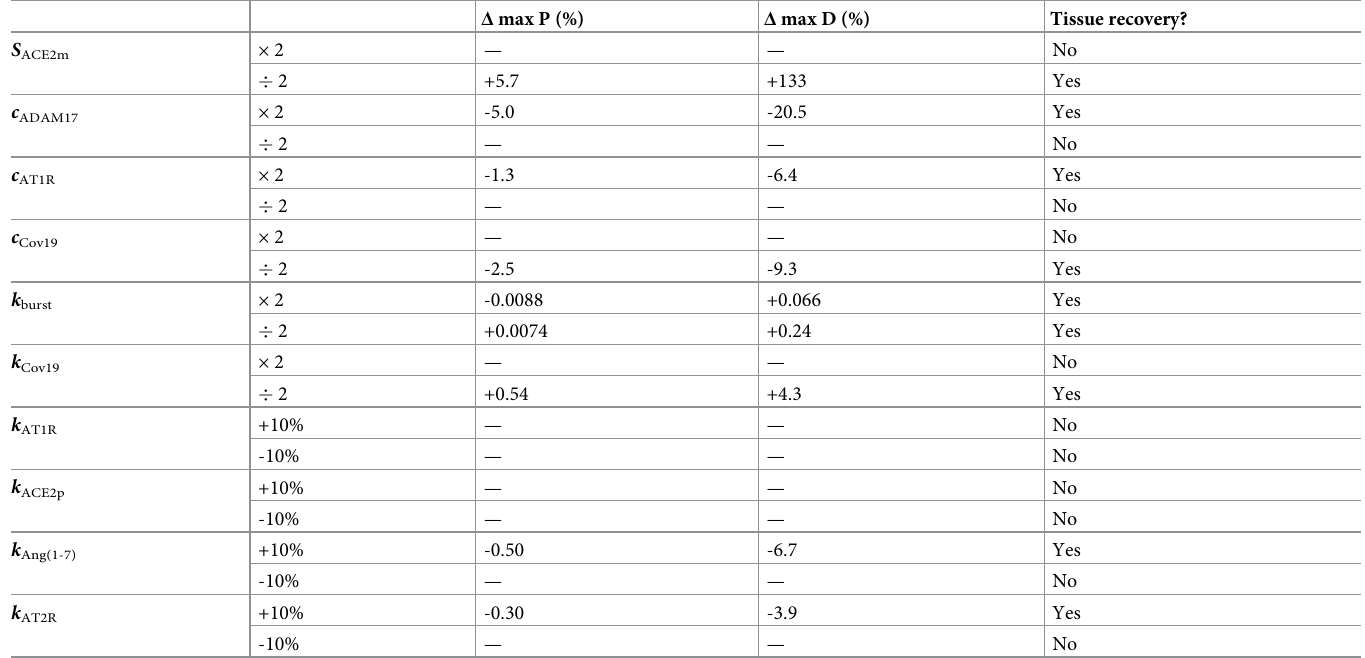
Table 2. Parameter sensitivity study. Percentage changes in peak viral load (P) and tissue damage (D) are reported only for cases that achieve tissue recovery.